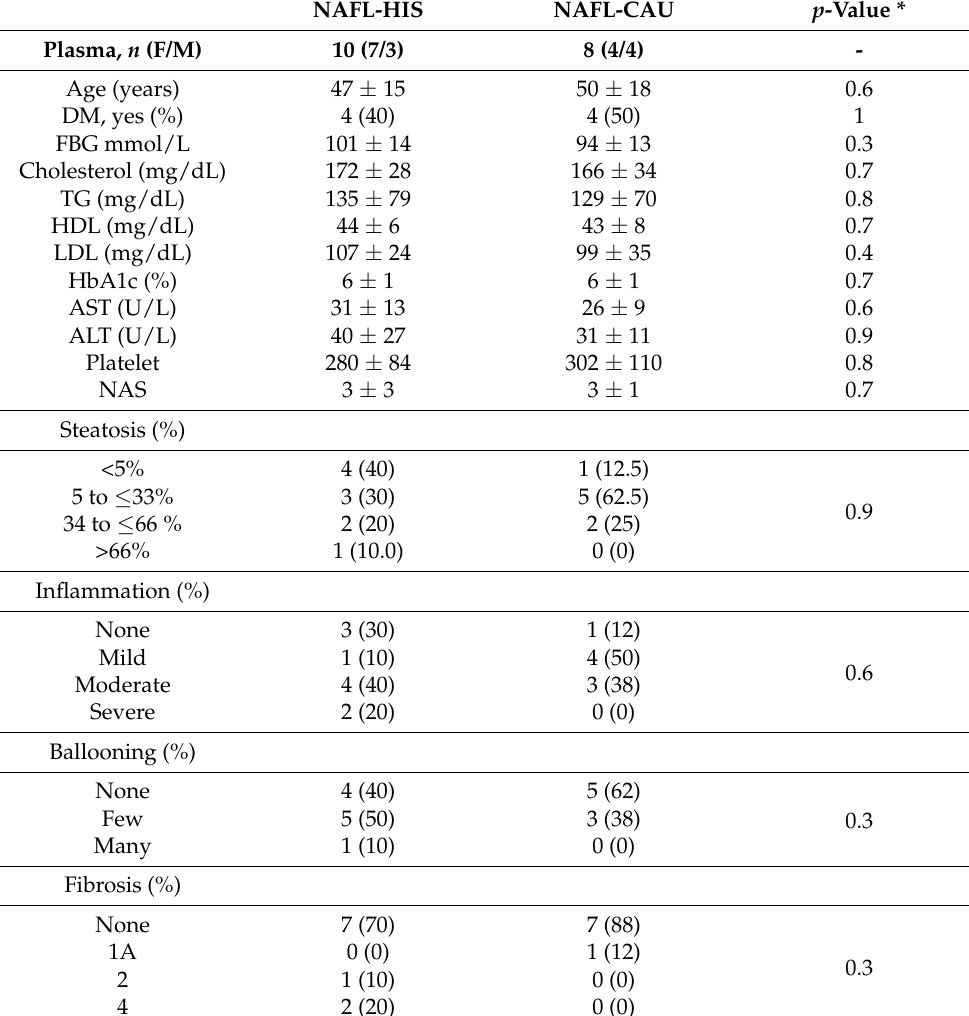
Table 1. Demographic, clinical, and histological characteristics of study subjects in primary analysis.